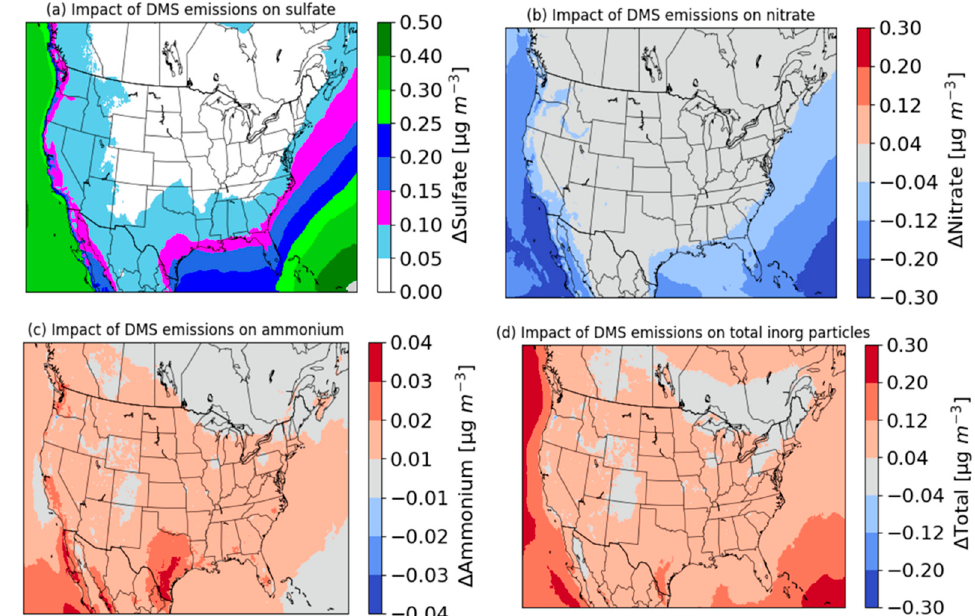
Figure 2. Predicted annual mean changes (WDMS—NODMS) in surface ( a ) sulfate, ( b ) nitrate, ( c ) ammonium, and ( d ) total inorganic particle concentrations by DMS emissions. Changes in inorganic particle concentrations are calculated as the net effect due to increases in sulfate and ammonium and decreases in nitrate concentrations.